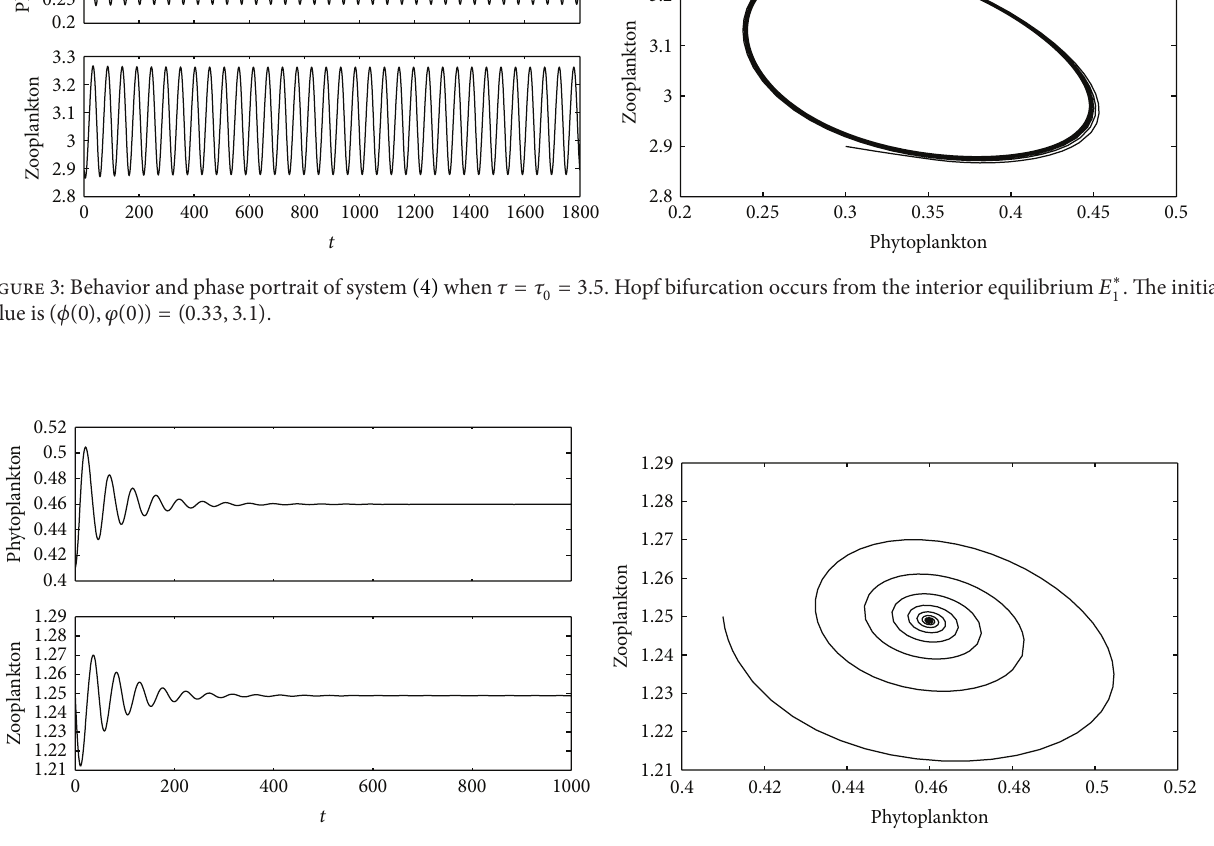
Figure 4: Behavior and phase portrait of system (4) with 𝜏 = 1 < 𝜏 0 shows the equilibrium 𝐸 ∗ 12 (0.4599, 1.2489) is stable. Here 𝜏 0 = 5.11 and the initial value is (𝜙(0),𝜑(0)) = (0.41, 1.25) .